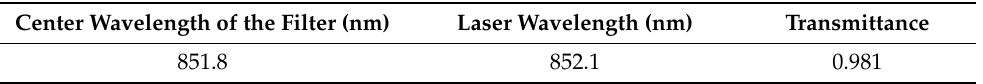
Figure 6. Schematic diagram of the experimental setup for the radiance measurement comparison. Table 4. The transmittance of the narrowband interference filter for 852 nm filter channel at a wavelength of 852.1 nm.